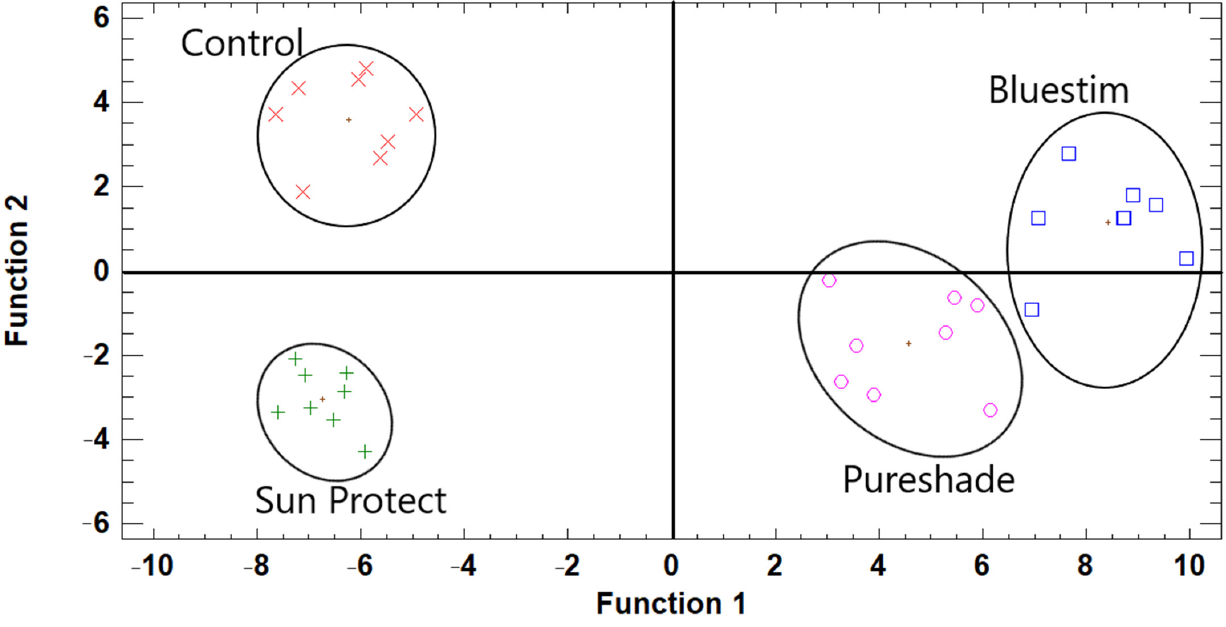
Figure 5. Plot of discriminant functions produced from the data of the second sampling on August 20th.